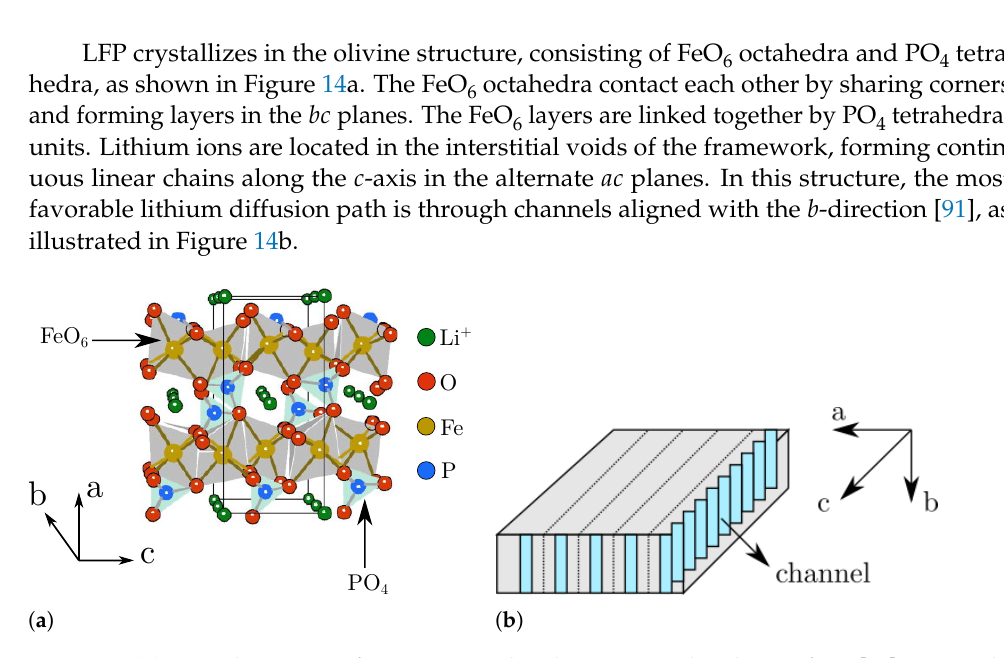
Figure 14. ( a ) Crystal structure of LFP. Reprinted with permission by Elsevier from [92], Copyright 2009. ( b ) Schematic illustration of lithium intercalation mechanism in LFP single crystal. Lithium ions diffuse along 1D channels in the b -direction, and channels are stacked in layers parallel to bc planes, indicated by the dotted lines.